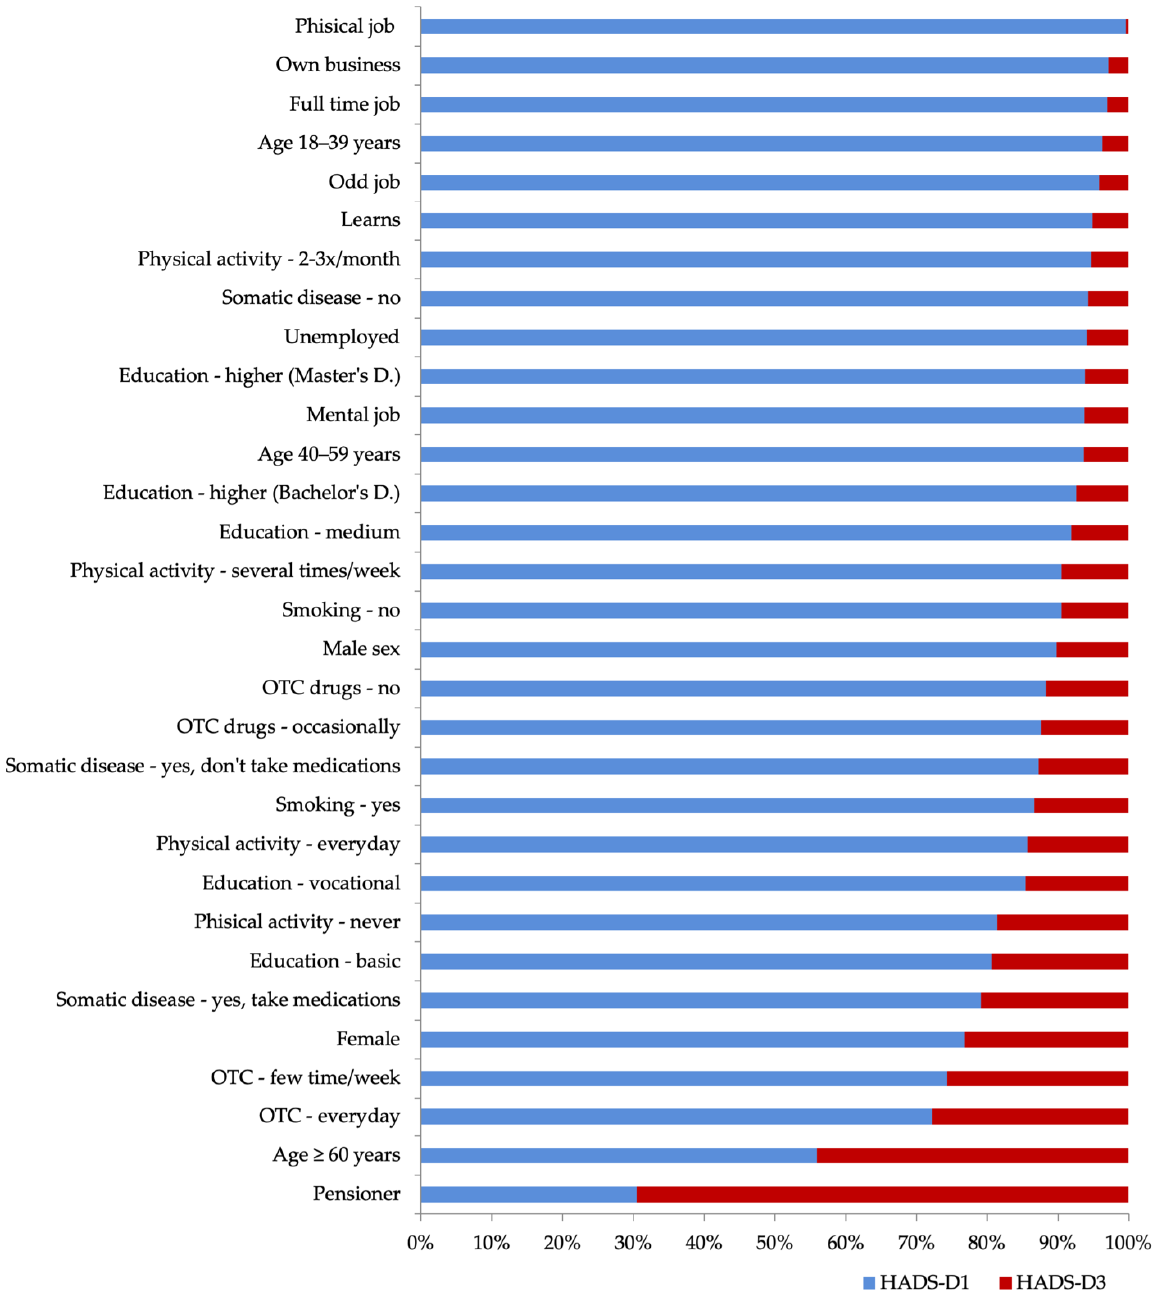
Figure 4. Data sorted by the percentage of depressive disorders (HADS-D3/HADS-D1) in particular subgroups of risk modifying factors that were statistically significant (the level of significance for all factors is p < 0.01).